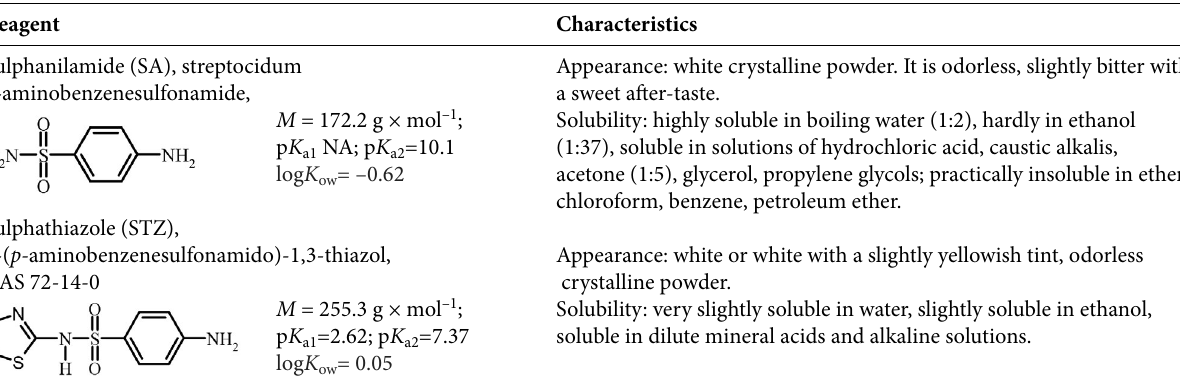
Table 2. Structural formula and some characterstics of investigated sulphanilamides Reagent